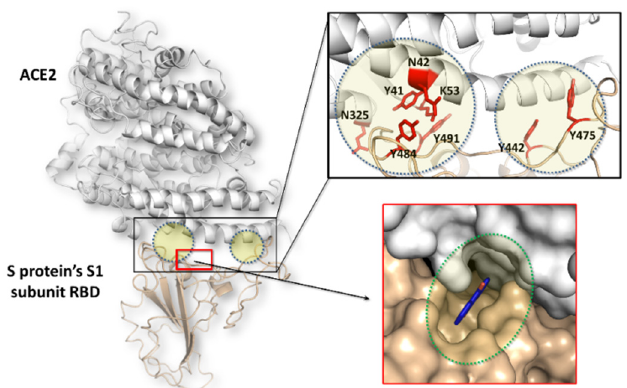
Figure 2. Representation of severe acute respiratory syndrome coronavirus (SARS-CoV-1) S protein-angiotensin I converting enzyme 2 (ACE2) complex (Protein Data Bank (PDB) code 6ACG). SARS-CoV-1 S protein is colored yellow, ACE2 is colored in white. The black box on the left figure indicates the protein–protein contact surface. The yellow dotted circles indicate the PPI hotspots (which are highlighted in red sticks in the close-up on the top right). The red box on the left figure indicates the position of the surface pocket identified at the protein–protein contact surface, which is detailed in a surface representation on the bottom-right close-up (the dotted ring indicates the possible arrangement of anthraquinones scaffold, shown in blue sticks).